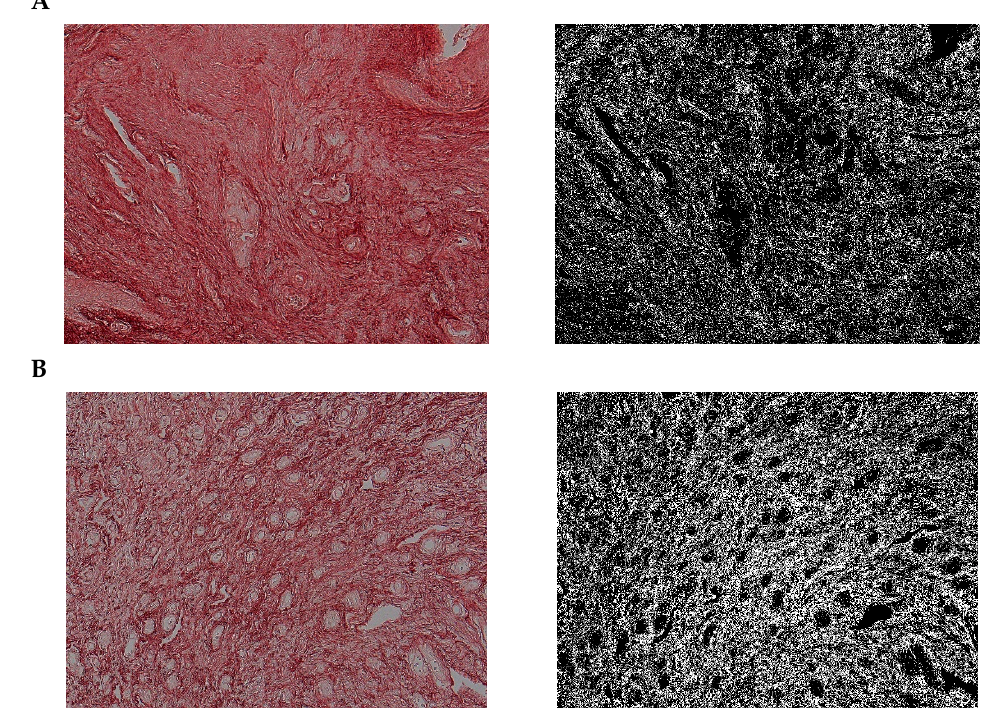
Figure 12. Segmentation before ( A ) and after ( B ) treatment (orcein).